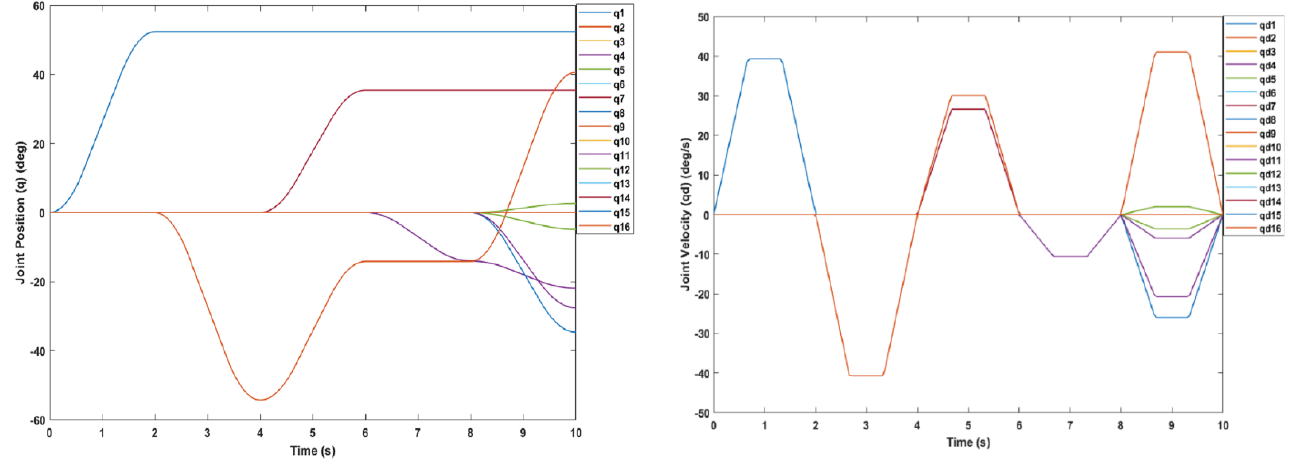
Figure 15. Joint angle trajectory positions ( left ) and velocity ( right ) from the home configuration to the final pose.